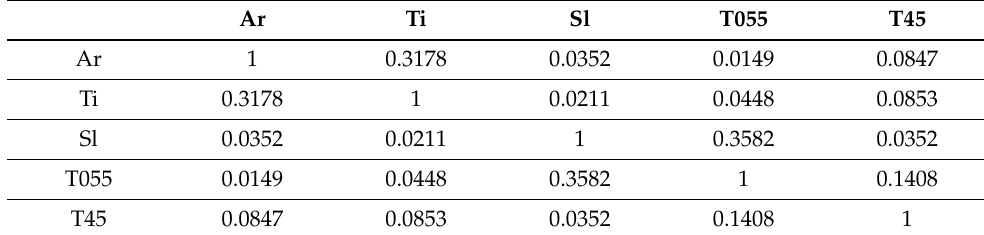
Table 2. Index of geometry match among five